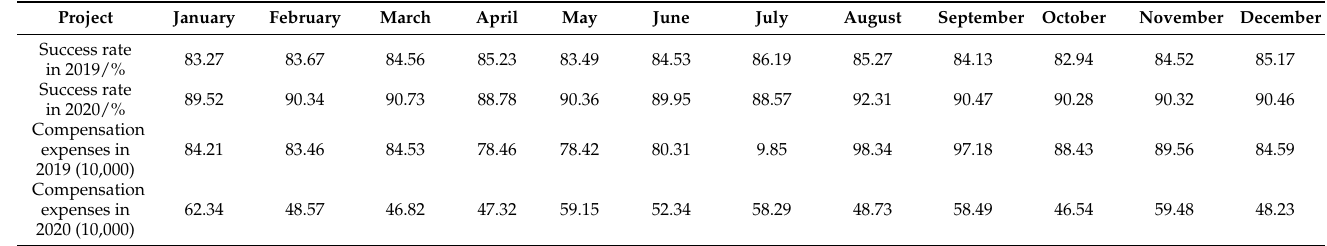
Table 6. Comparison of success rate and compensation cost data for 2019 and